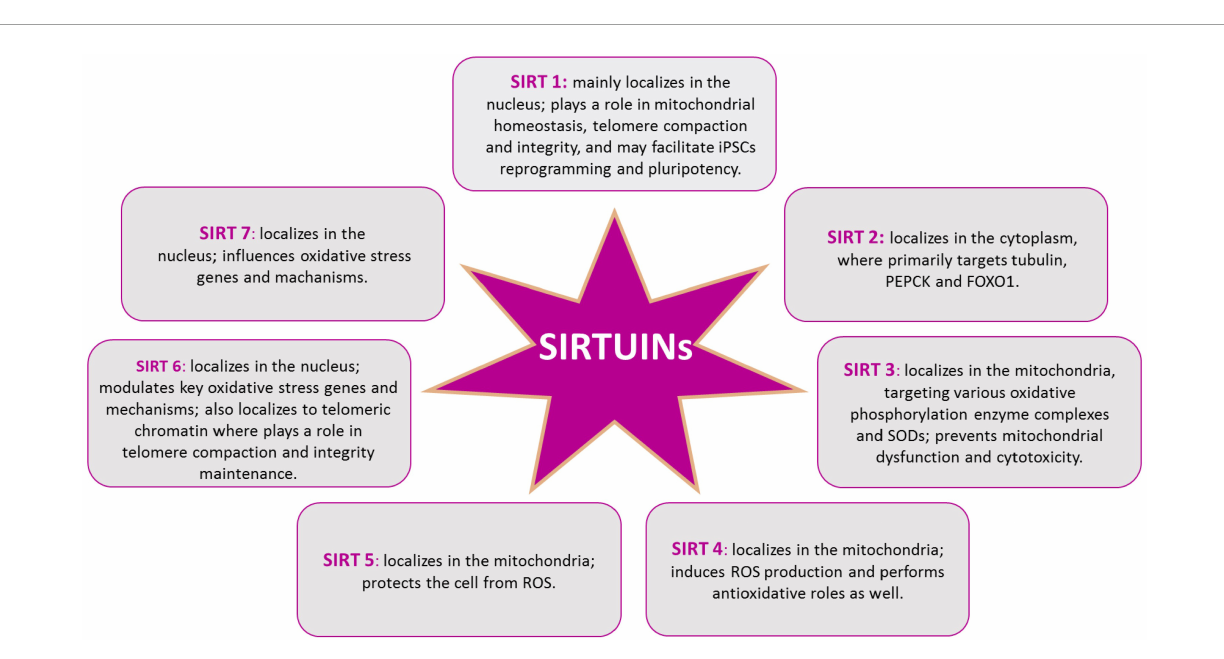
FIGURE6 SIRTs protein family. Intracellular distribution of SIRTs in the cytoplasm, the mitochondria, and the nucleus, allows them to play different roles in cellular redox